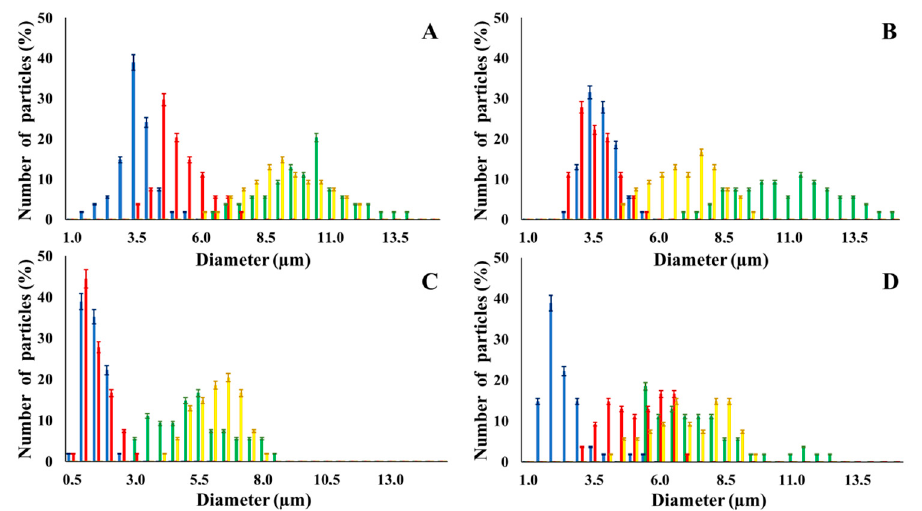
Figure 2. NMP diameters. Blue: dry d-NMP; green: swollen d-NMP; red: dry w-NMP; yellow: swollen w-NMP. ( A ) CM-dextran; ( B ) Hyaluronic Acid; ( C ) Alginate; ( D ) Dextran.